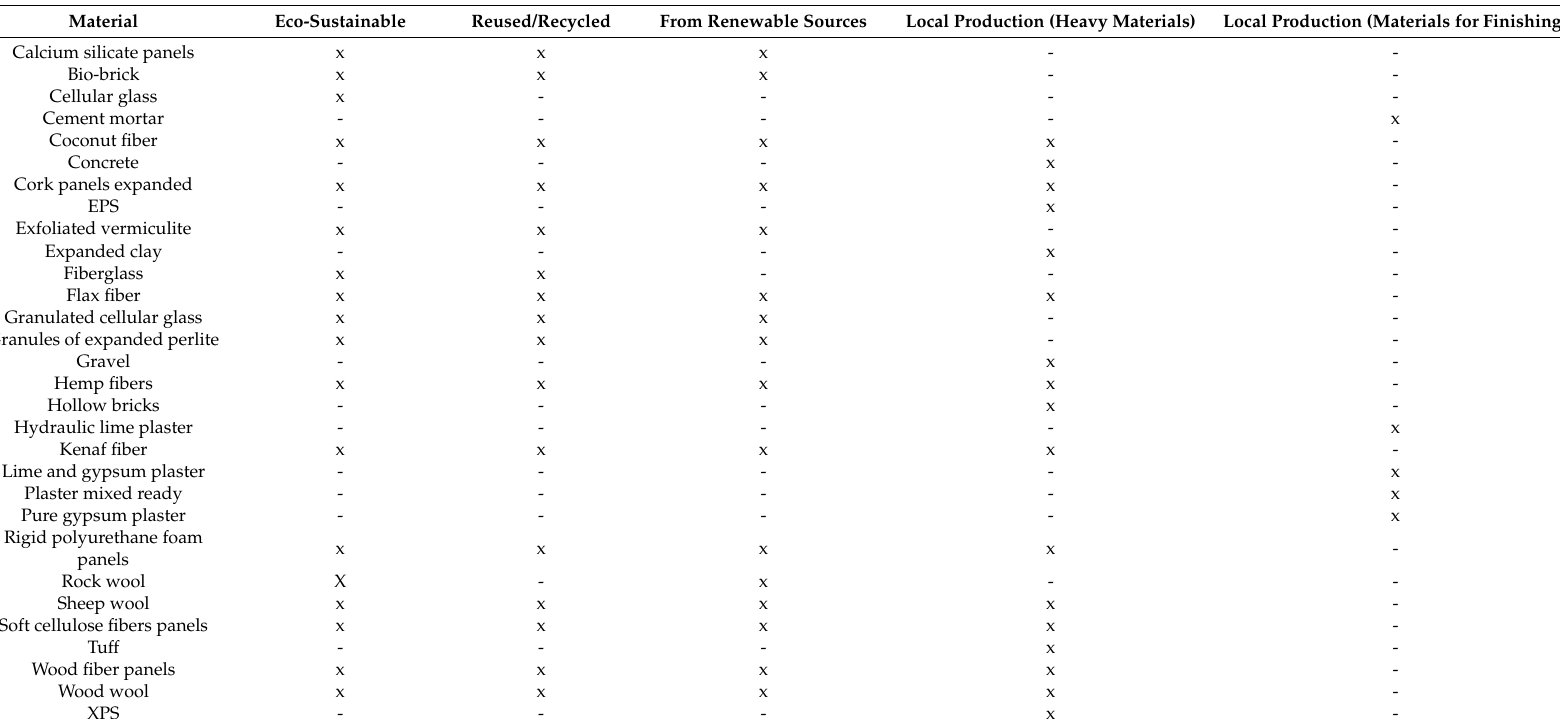
Table 3. Evaluation of the eco-sustainability of the materials according to the ITACA